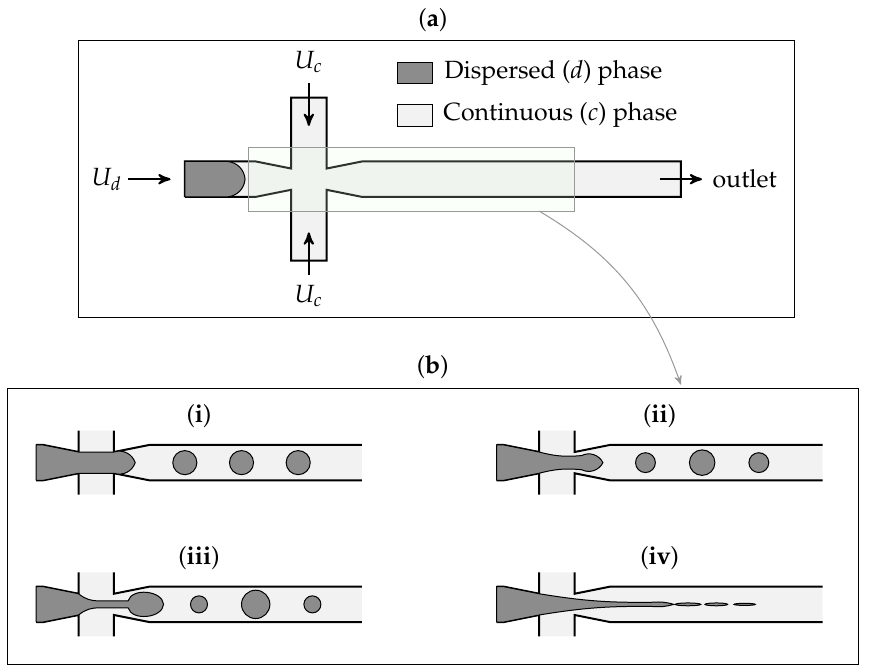
Figure 1. ( a ) Flow-focusing microfluidic channel; ( b ) schematic of different regimes in flow-focusing microfluidics: ( i ) squeezing, ( ii ) dripping, ( iii ) jetting and ( iv )